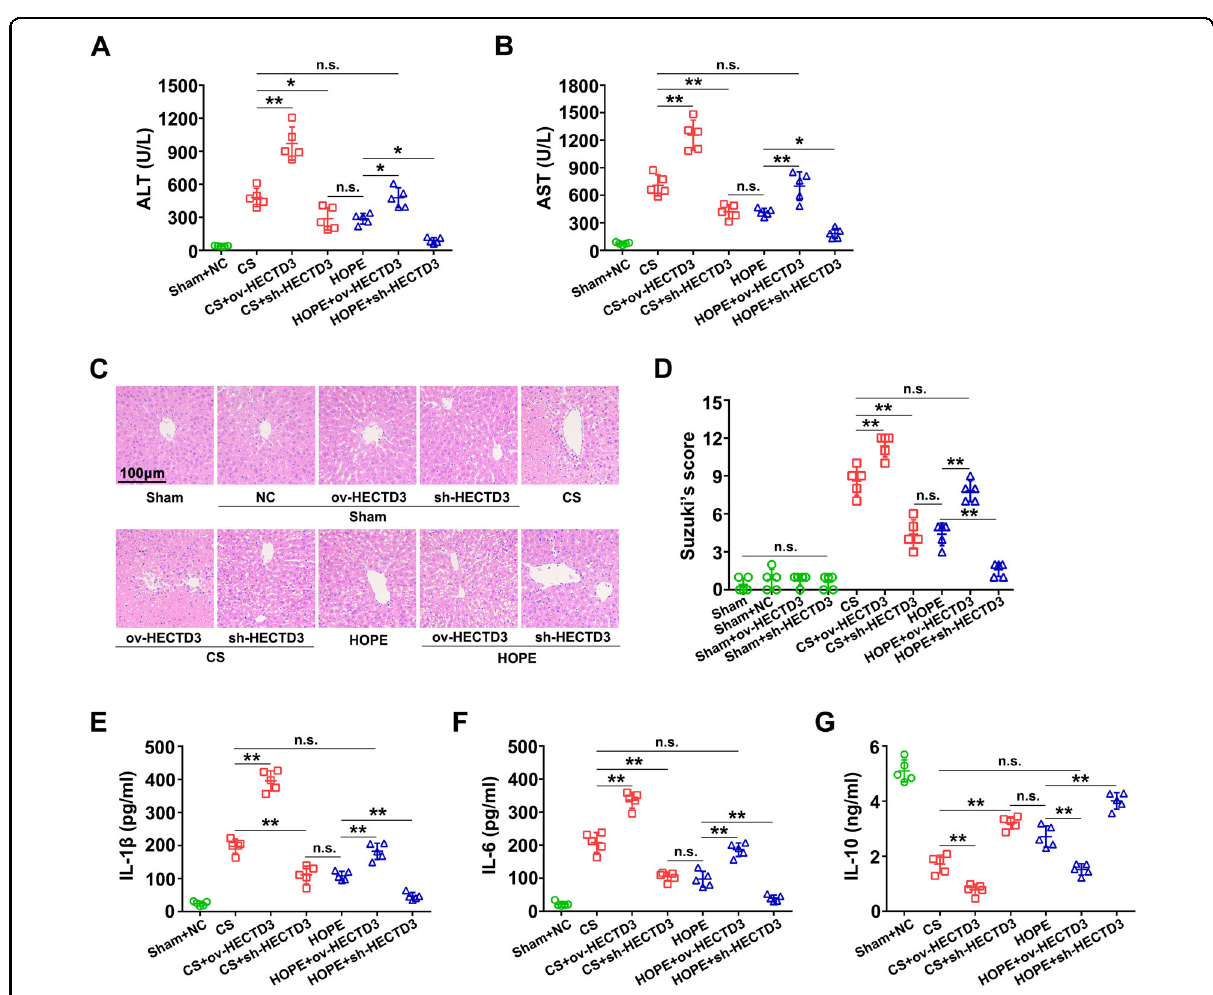
Fig. 4 HOPE reduces DCD liver IRI and in fl ammation by inhibiting HECTD3 in rats. Rats were infected with ov-HECTD3 or sh-HECTD3 AAV8. The rats in the sham group were infected with or without AAV8 NC served as the negative control. After the specimen collection, the following analysises were performed. A , B ALT and AST activities in perfusate. Data are mean ± SD, n.s., not signi fi cant; * P < 0.05 and ** P < 0.01 by one-way ANOVA followed by Tukey ’ s test. n = 5 per group. C Histological damage in liver of rats. H&E staining was performed on paraf fi n-embedded section of rat liver tissues. Scale bar = 100 μ m. D Histological scores were analyzed according to Suzuki ’ s criteria. Data are mean ± SD, n.s., not signi fi cant; ** P < 0.01 by one-way ANOVA followed by Tukey ’ s test. n = 5 per group. E – G Liver tissues expression levels of IL-1 β , IL-6, and IL-10 were analyzed with